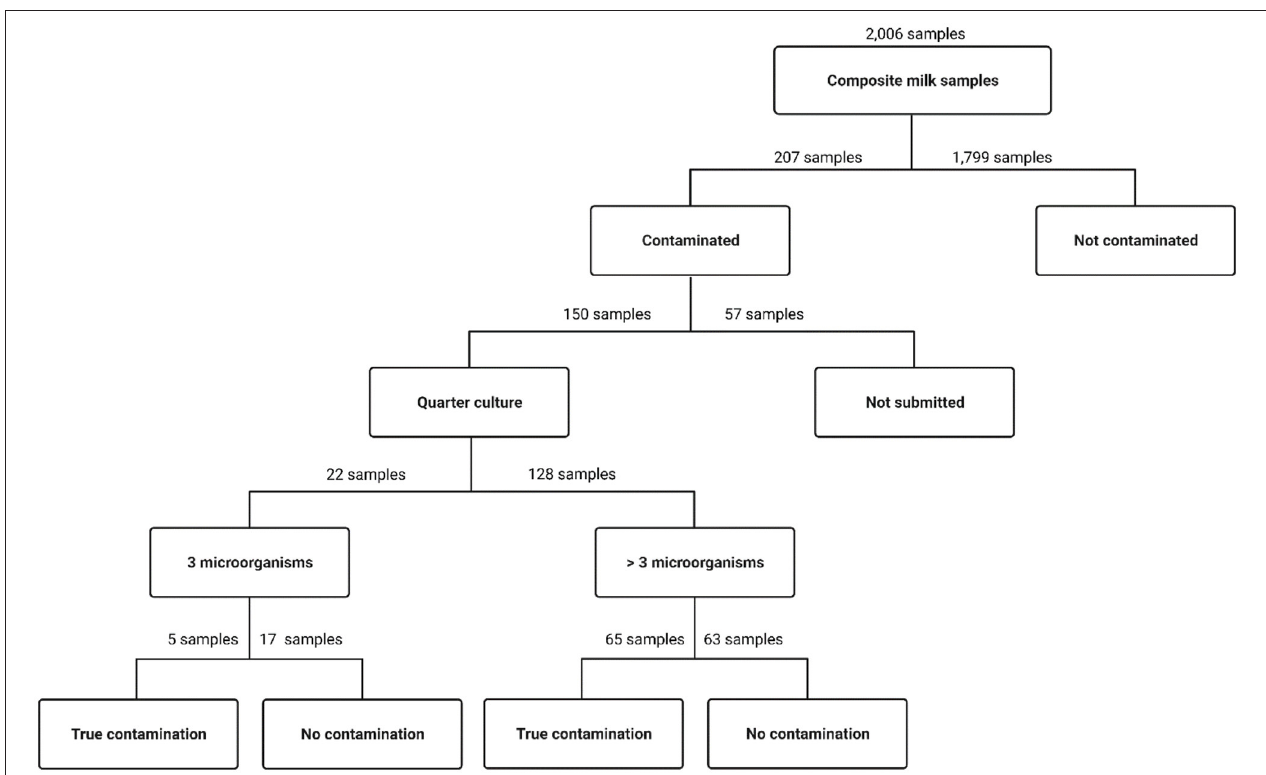
FIGURE 2 | Flow chart describing the number of lab-pooled milk samples submitted for bacterial culture; the number of lab-pooled samples exhibiting growth of ≥ 3 microorganisms (“contaminated”) or < 3 microorganisms (“not contaminated”); the number of lab-pooled samples submitted for follow-up quarter-level culture (“quarter culture”), divided into those that contained exactly “3 microorganisms” in the lab-pooled culture vs. those that contained “ > 3 microorganisms” in the lab-pooled culture; and the number that were classified as truly contaminated (“true contamination”, i.e., at least 1 quarter milk sample with ≥ 3 microorganisms) or not contaminated (“no contamination”, i.e., no quarters with ≥ 3 microorganisms).